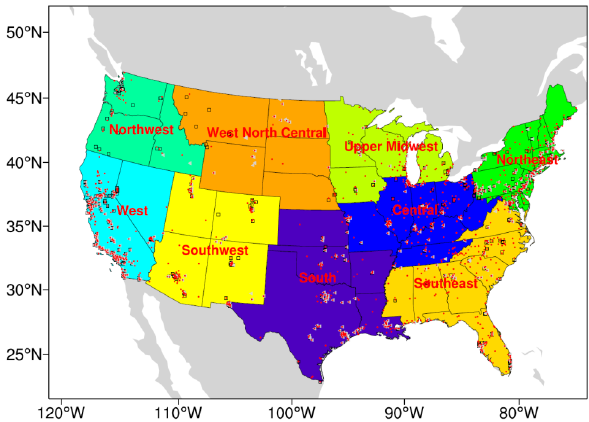
Fig. 1. 12km by 12km simulation domain with nine climate regions in the US. The red points ( ∼ 1200), the gray triangles ( ∼ 450) and black squares ( ∼ 450) represent the observational sites of O 3 , NO 2 and CO, respectively, obtained from Air Quality System (AQS, http://www.epa.gov/ttn/airs/airsaqs/detaildata/downloadaqsdata.htm).